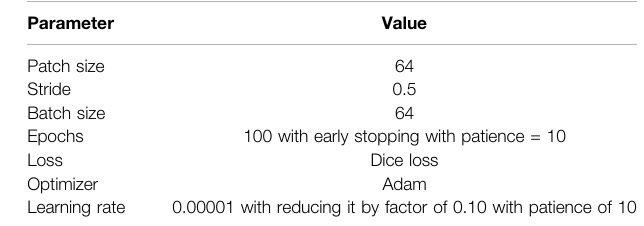
TABLE 1 | Parameters used for training 2D CNN with adjacent slices.